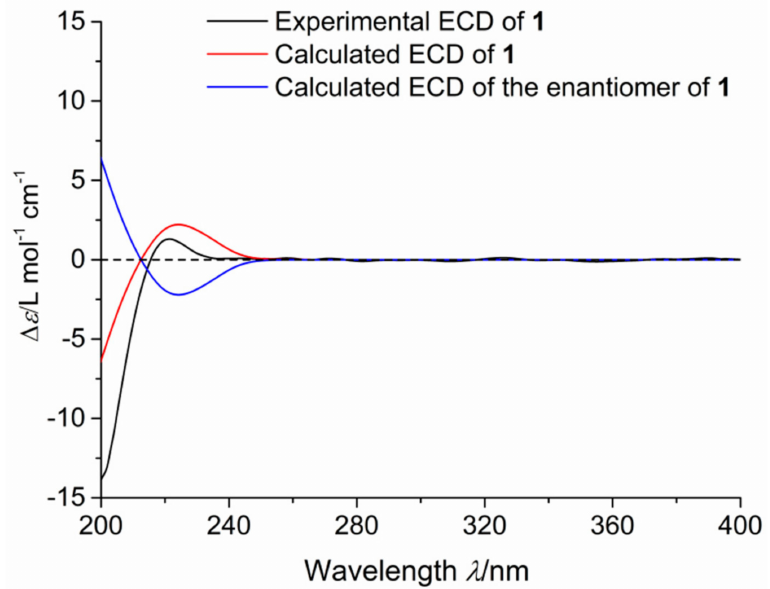
Figure 4. Experimental ECD for 1 and calculated ECD spectra for 1 and its